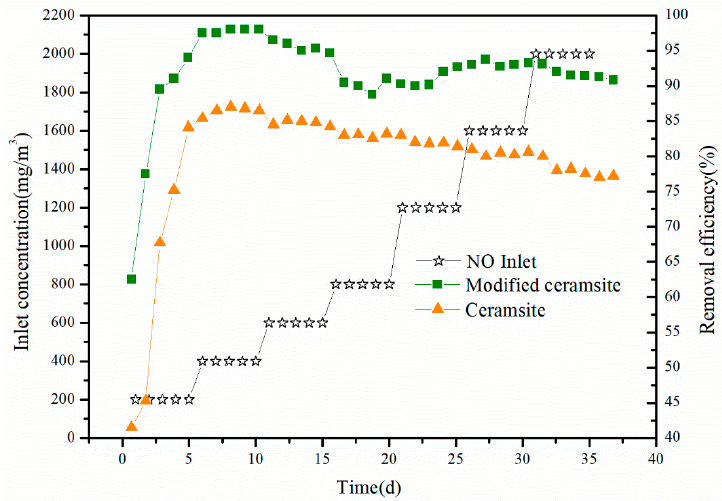
Figure 7. NO concentrations and removal efficiencies for modified ceramsite and natural ceramsite as fillers in the biotrickling filter during the operation period. fillers in the biotrickling filter during the operation period. Table 3. Performance of some typical bioreactors for NO removal. Table 3. Performance of some typical bioreactors for NO